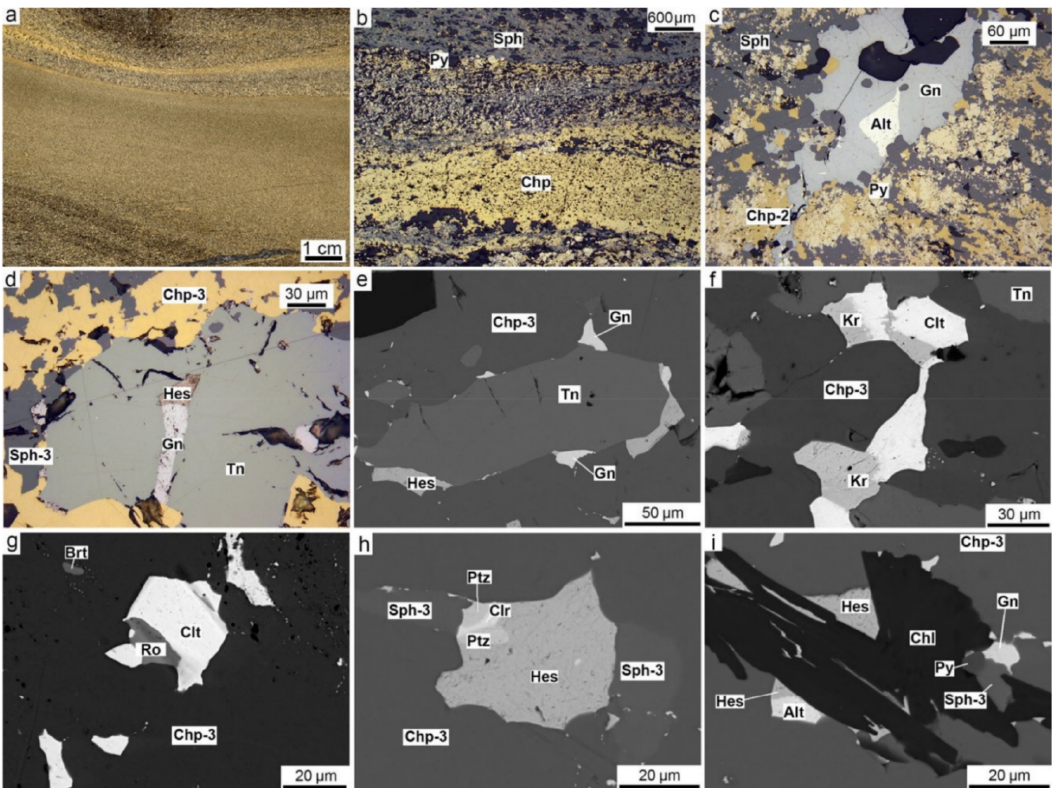
Figure 9. Mineralogical features of chalcopyrite-rich diagenites of the Molodezhnoe deposit: ( a ) Chalcopyrite-rich diagenites in sulfide turbidites; ( b ) intercalation of chalcopyrite- and sphalerite-rich diagenites; ( c ) altaite inclusion in galena veinlet; ( d , e ) intergrowth of hessite, galena and tennantite in chalcopyrite-3 and sphalerite-3; ( f ) clausthalite and kurilite in authigenic chalcopyrite-3; ( g ) clausthalite and roquesite in chalcopyrite-3; ( h ) assemblage of hessite, coloradoite, petzite, and sphalerite-3 in chalcopyrite-3; ( i ) replacement of chalcopyrite-3, hessite and altaite by chlorite. ( a ) Polished sample; ( b – d ) reflected light; ( e – i ) BSE